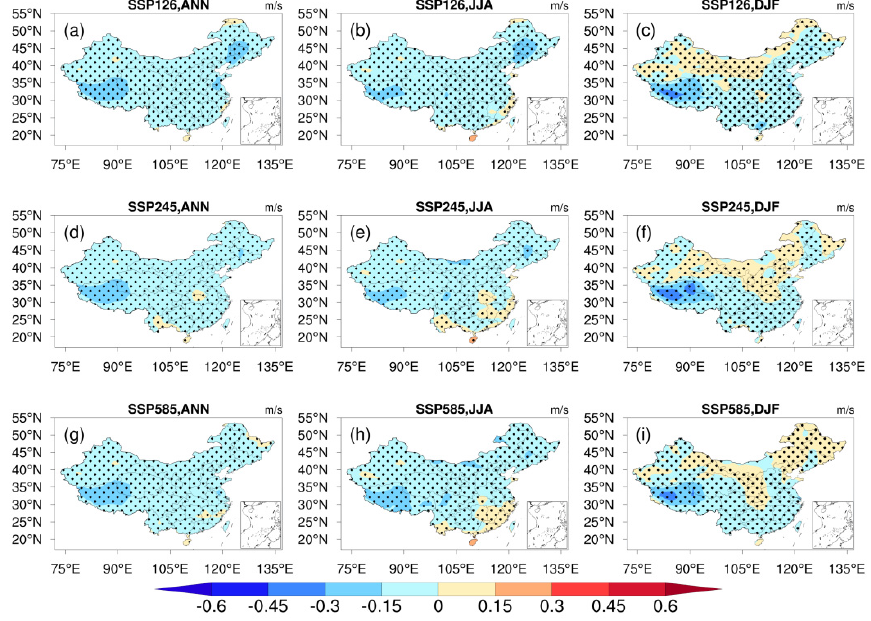
Figure 10. Projected changes of NWS (m · s − 1 ) under ( a – c ) SSP1-2.6, ( d – f ) SSP2-4.5, and ( g – i ) SSP5-8.5 for the period 2021–2060 relative to the reference period (1975–2014). The first column ( a , d , g ) is annual, the second column ( b , e , h ) is summer, and the third column ( c , f , i ) is winter variation. Black solid dots indicate those grids with statistically significant changes at the 95% level.